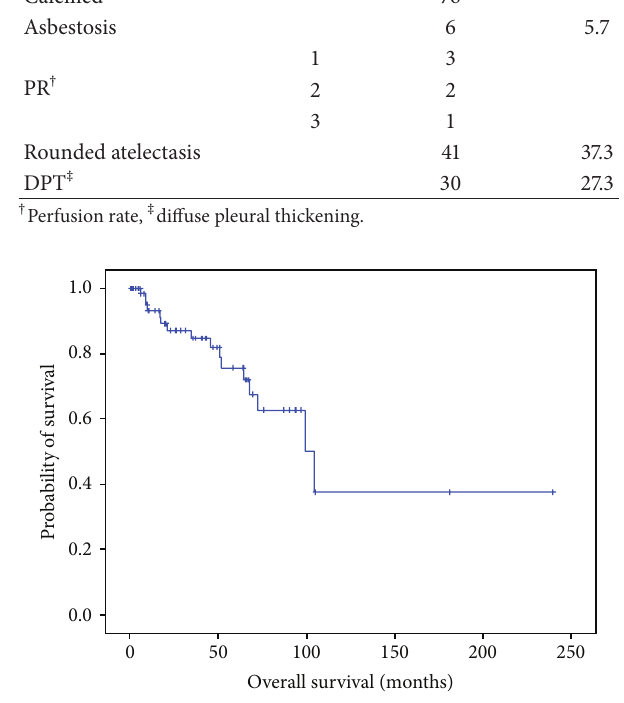
Figure 1: Overall survival of patients with benign asbestos-related pleural effusions at Okayama Rosai